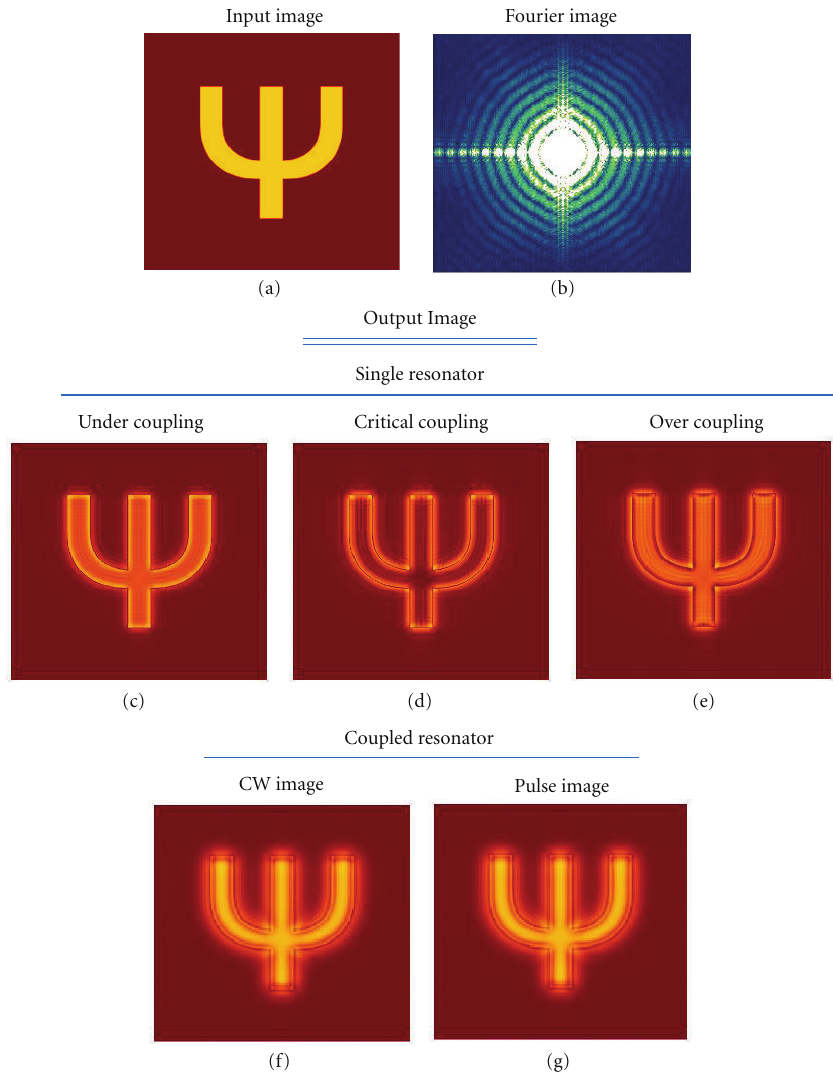
Figure 3: (a) Original image injected into the cavity. (b) Fourier-transformed input image. The full width at half maximum of the Fourier image is δk = 4 . 9mm − 1 . (c)–(e) Reflected images obtained using continuous wave input light for under ( R 1 = 0 . 7, R 2 = 0 . 5, Δ k = 13 . 0mm − 1 ), critical ( R 1 = 0 . 5, R 2 = 0 . 5, Δ k = 9 . 0 mm − 1 ), and over coupling ( R 1 = 0 . 5, R 2 = 0 . 7, Δ k = 13 . 0mm − 1 ) conditions,